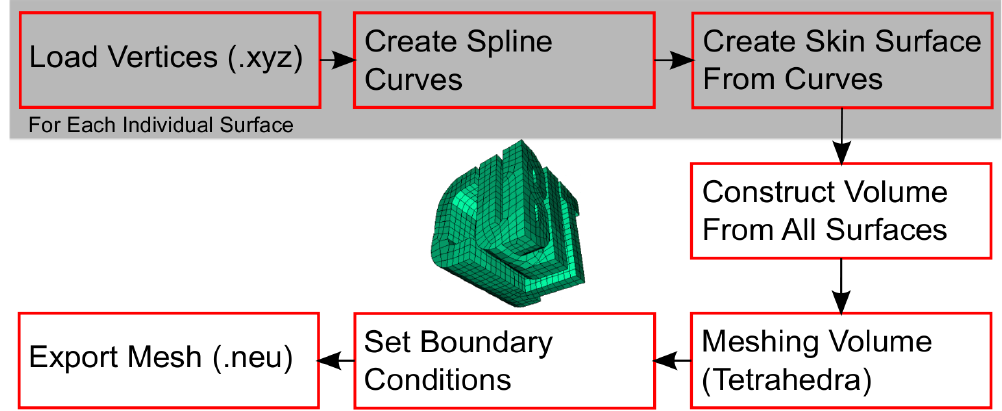
Fig. 1. Workflow of the mesh generation process using Cubit